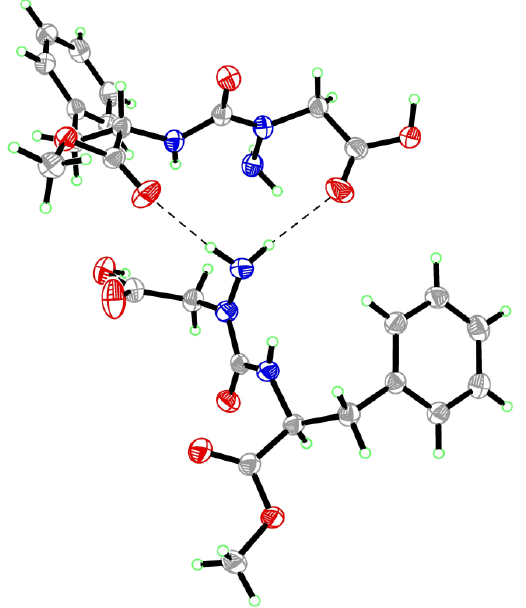
Figure 7. Packing of aza-aspartame 9 in the